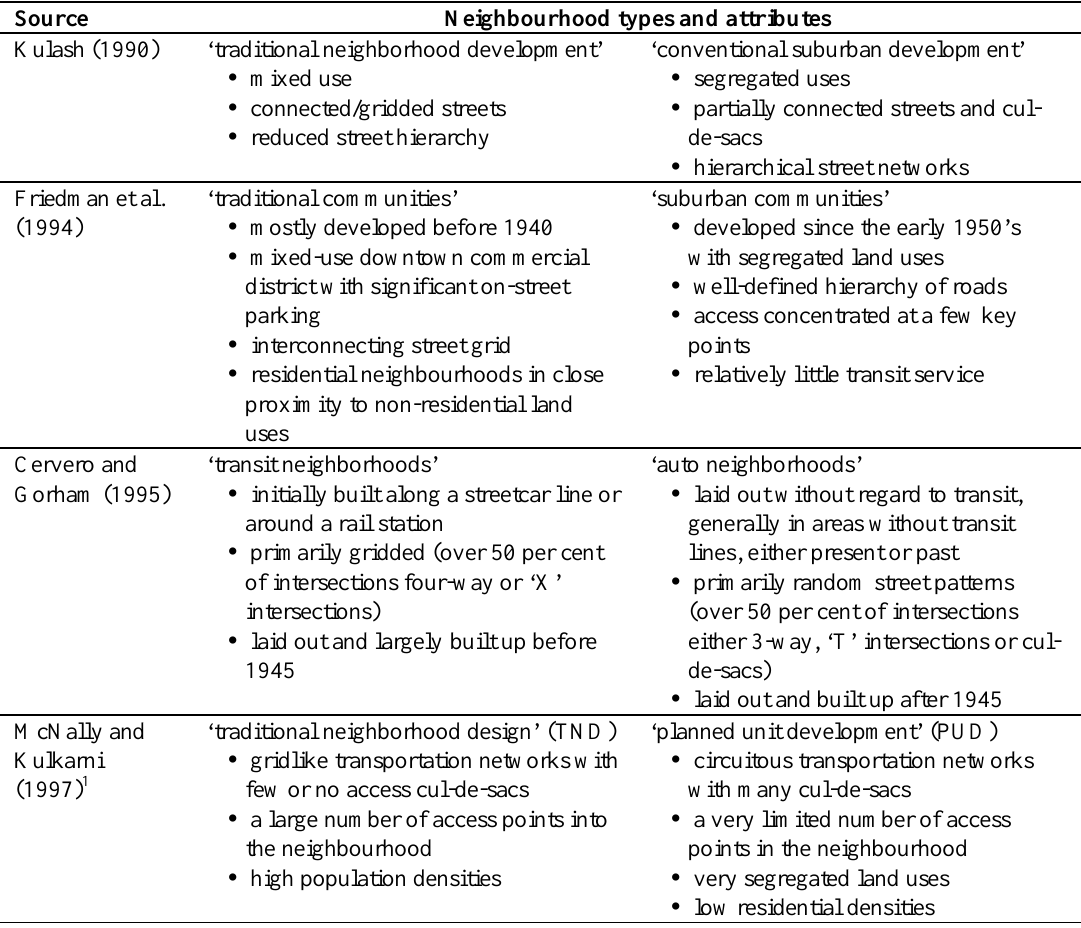
Table 2. A selection of neighbourhood types and their component attributes